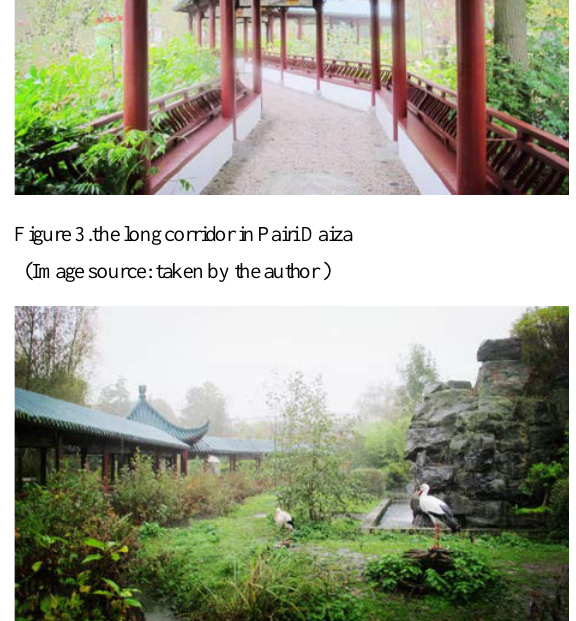
Figure 5.the tea house in Pairi Daiza (Image source: taken by the author